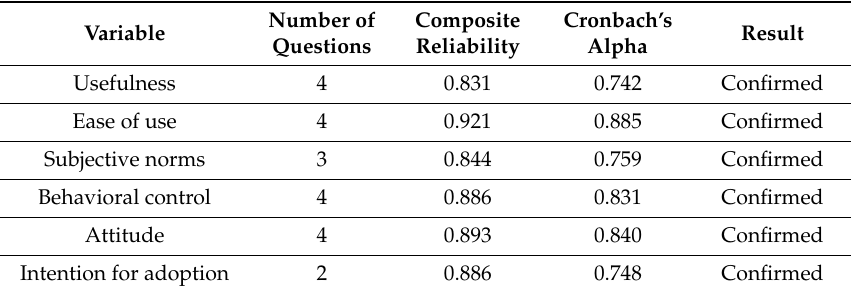
Table 2. The reliability of the questionnaire’s items.